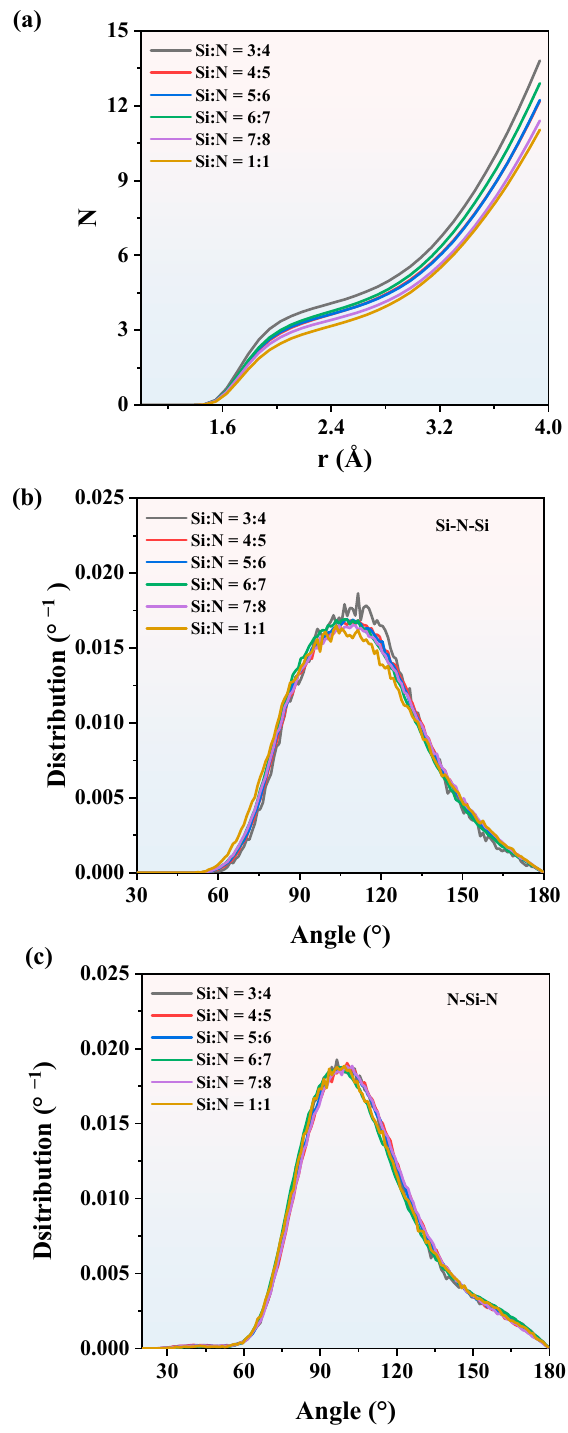
Figure 9. ( a ) The CNs of SiN x at 3000 K. The BADs of ( b ) Si-N-Si and ( c ) N-Si-N at 3000